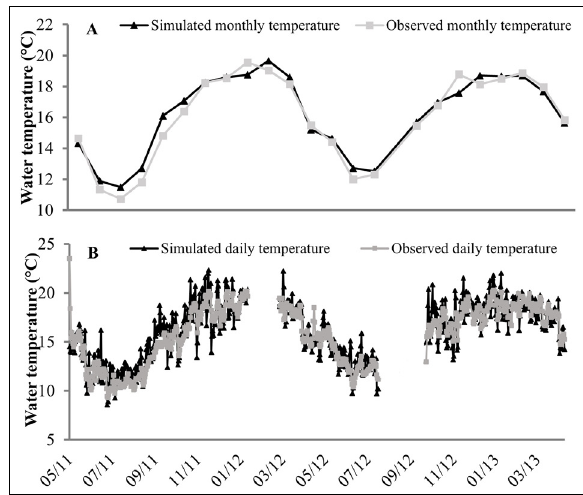
Figure 3: Hydrothermographs of monthly model (A) and daily model (B) for March 2011 to April 2013, both simulated (shown in black) and observed (shown in grey) water temperatures for Klaserie River, South Africa. The gaps in B are due to periods of missing observational data.